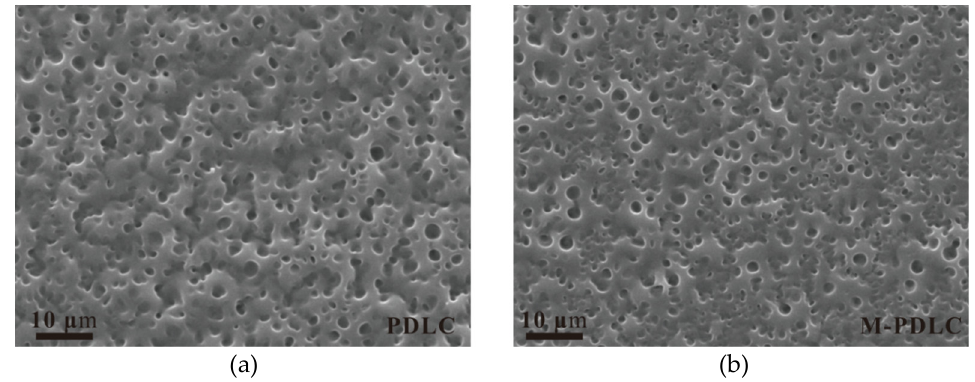
Figure A2. The SEM images of the PDLC and M-PDLC. ( a ) PDLC, ( b ) M-PDLC.